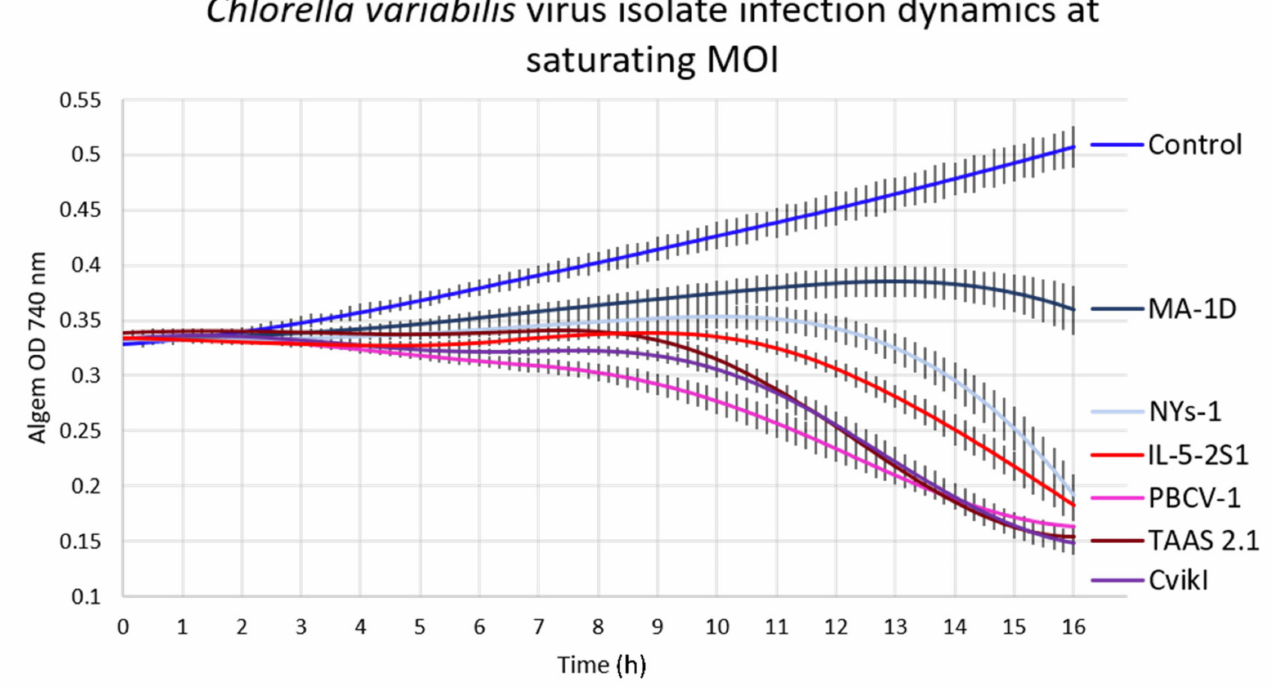
Figure 2. Infection of Chlorella variabilis cultures at an MOI of 5 with PBCV-1, MA-1D, NYs-1, TAAS 2.1, CviKI, and IL-5-2S1 virus isolates and uninfected control cultures of Chlorella variabilis strain CCAP 211/84. The plotted values are the average of 3 biological replicates with standard